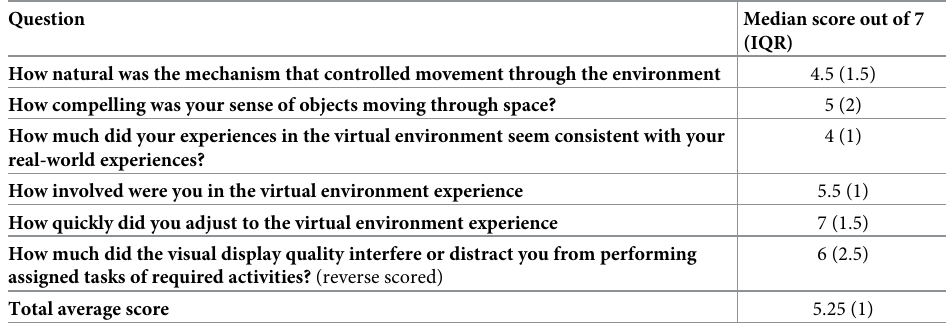
Table 2. Item and total scores for the presence questionnaire (PQ). Question How natural was the mechanism that controlled movement through the environment How compelling was your sense of objects moving through space? How much did your experiences in the virtual environment seem consistent with your real-world experiences? How involved were you in the virtual environment experience How quickly did you adjust to the virtual environment experience How much did the visual display quality interfere or distract you from performing assigned tasks of required activities? (reverse